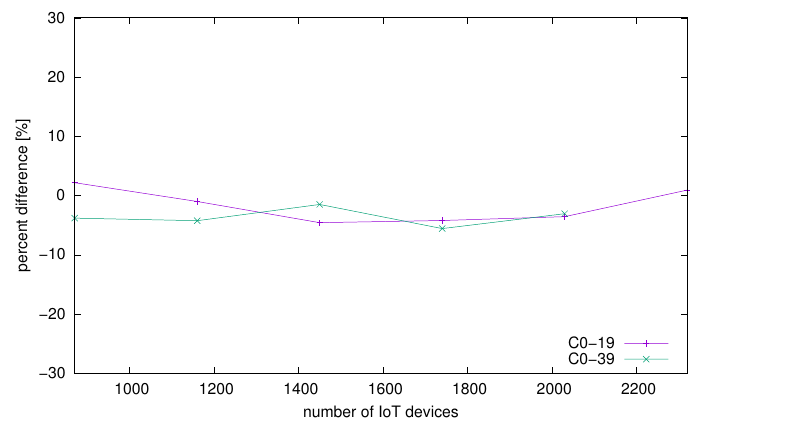
− t docker t physical